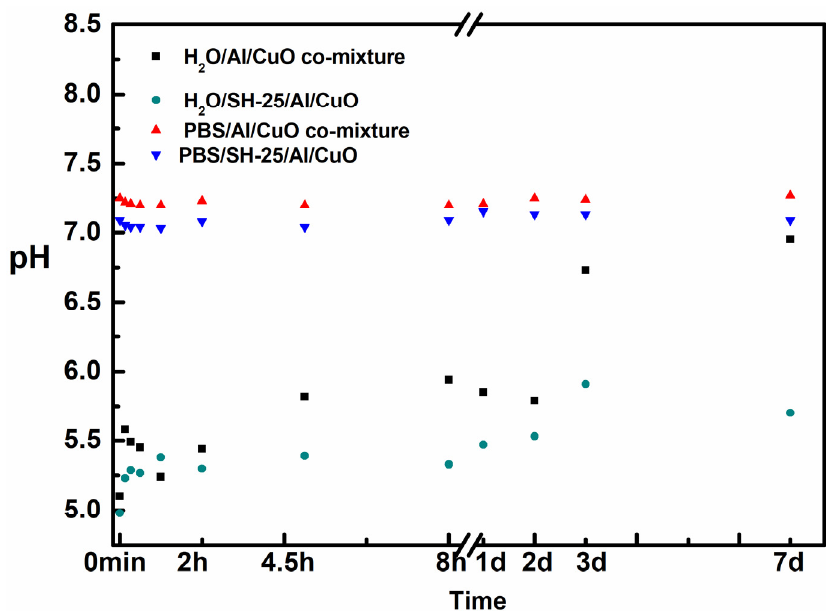
Figure 4. Investigation of the pH solution at room temperature. DLS and zeta-potential measurements were used to track the features of CuO and Al NPs as they were assembled [21,31].